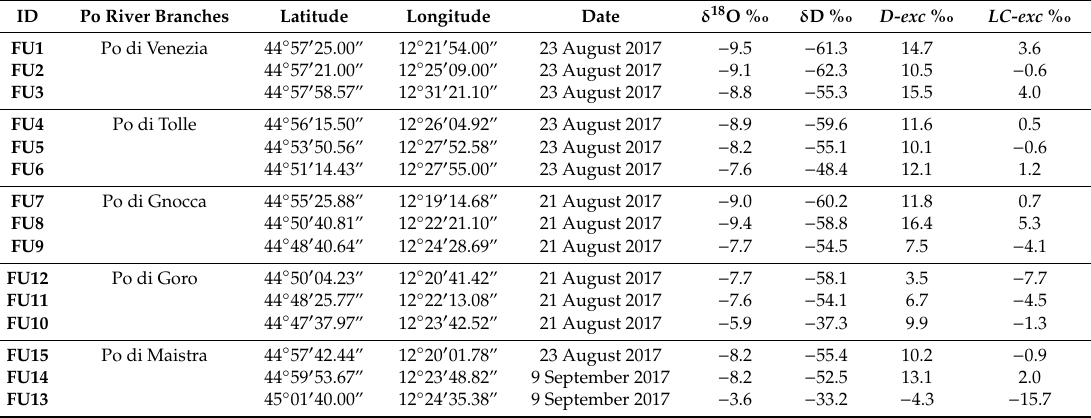
Table 3. Hydrogen and oxygen isotopic composition and relative D-exc and LC-exc in waters collected in the distinct branches of the Po Delta (cf. inset of Figure 1). Coordinates of the sampling sites are also